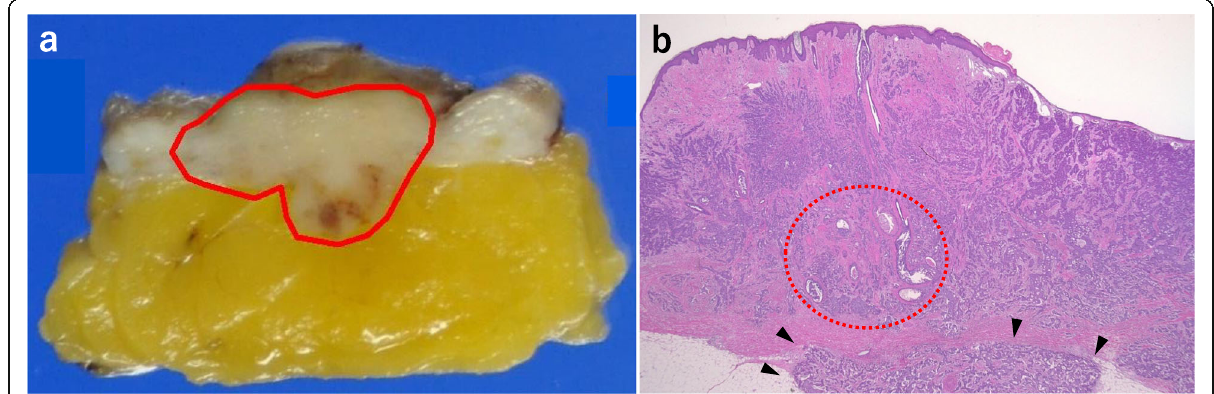
Fig. 4 Histopathological findings. a The boundary of the tumor is delineated with a red line on the macroscopic image. The tumor is localized within epithelial and subcutaneous adipose tissue. The macroscopic image shows extensive infiltration and growth of tumor cells. b At the lower peripheral area, tumor cells are infiltrating into the adipose tissue across the desmoplastic border (black arrow). The infiltrating tumor cells show trabecular, sheet-like, acinar, and nesting growth patterns, with a few ductal carcinomas in situ with comedo necrosis (red dotted